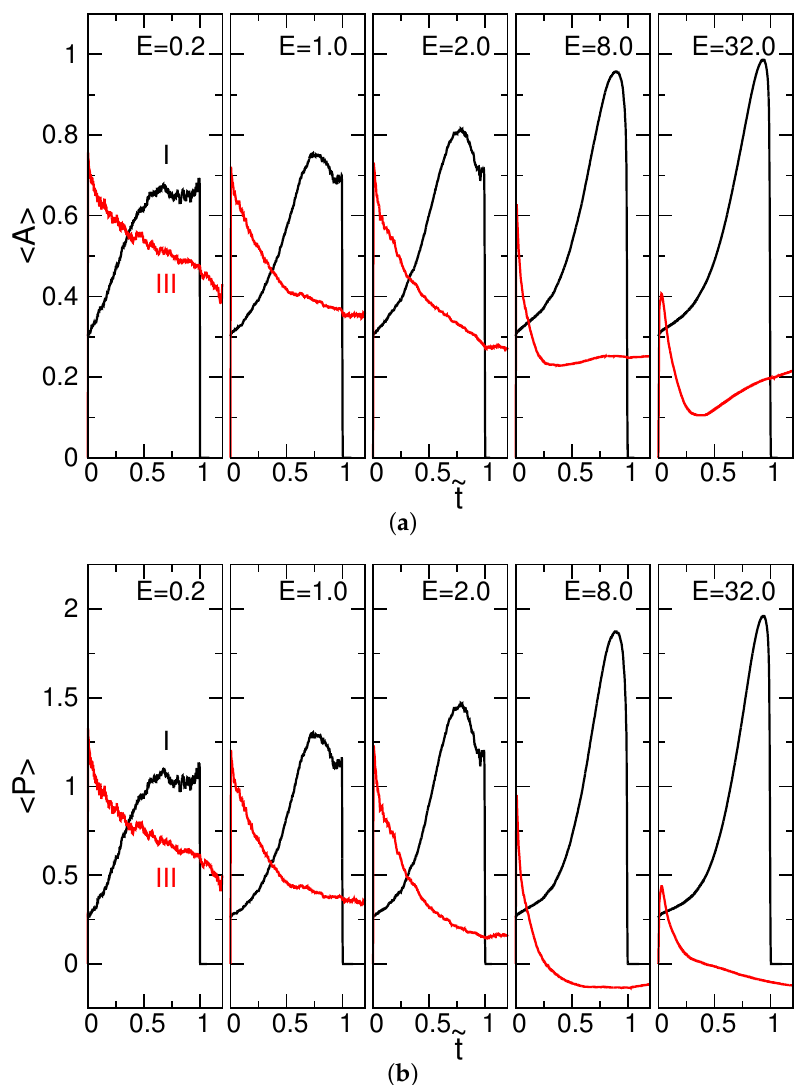
Figure 3. Average variations of ( a ) the asphericity (cid:104) A (cid:105) and of ( b ) the prolateness (cid:104) P (cid:105) in the cis region (I) and trans-region (III) as a function of the scaled time ˜ t , for N = 256 at different driving electric fields E (indicated in the